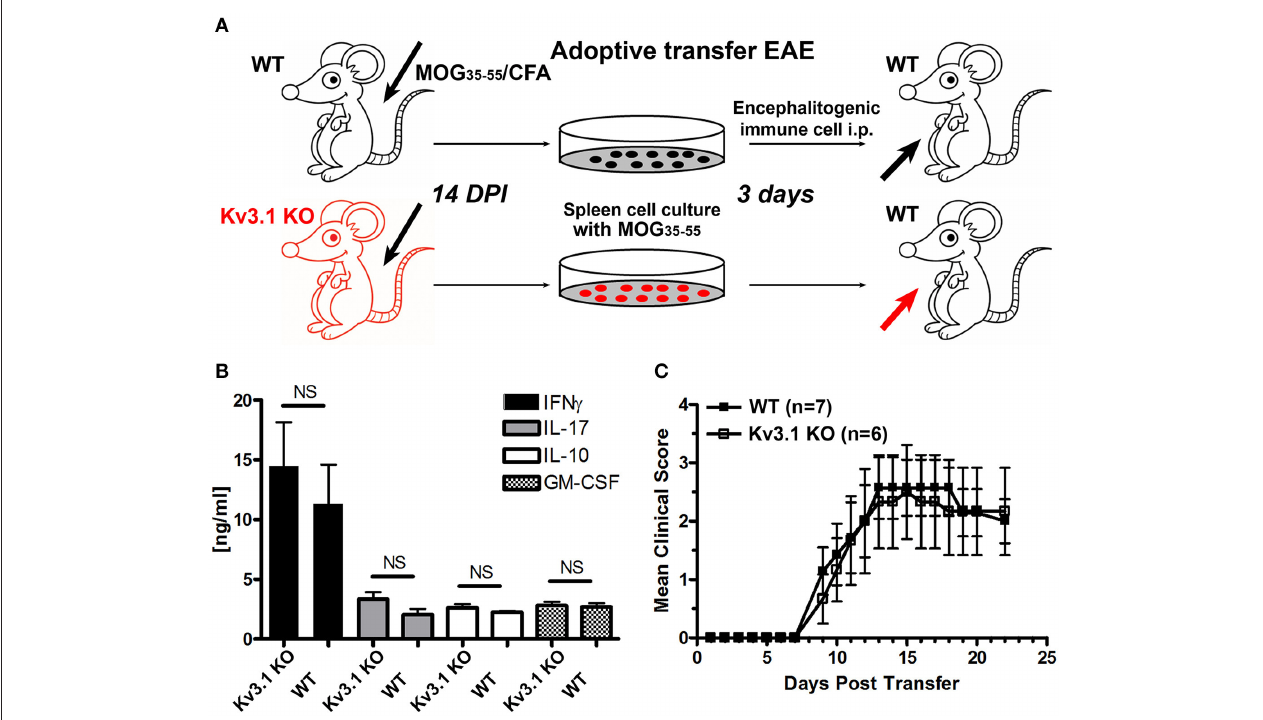
FIGURE 2 | Efficacy of immune cells from Kv3.1 KO mice in adoptive transfer EAE. (A) Diagram of adoptive transfer EAE. First, chronic EAE was induced with MOG 35 – 55 on both Kv3.1 KO mice and WT littermates. At 14 DPI when clear EAE signs were observed, their splenocytes were removed and cultured in vitro with stimulation by MOG 35 – 55 for 3 days. These cells were then transferred into WT C57BL/6 mice. (B) No significant differences in cytokine production between Kv3.1 KO and WT cells was observed. The levels of IFN γ , IL-17, IL-10, and GM-CSF were measured in the supernatants by ELISA. (C) No significant difference in EAE clinical scores was observed between the mice that received WT lymphocytes and those that received Kv3.1 KO lymphocytes.